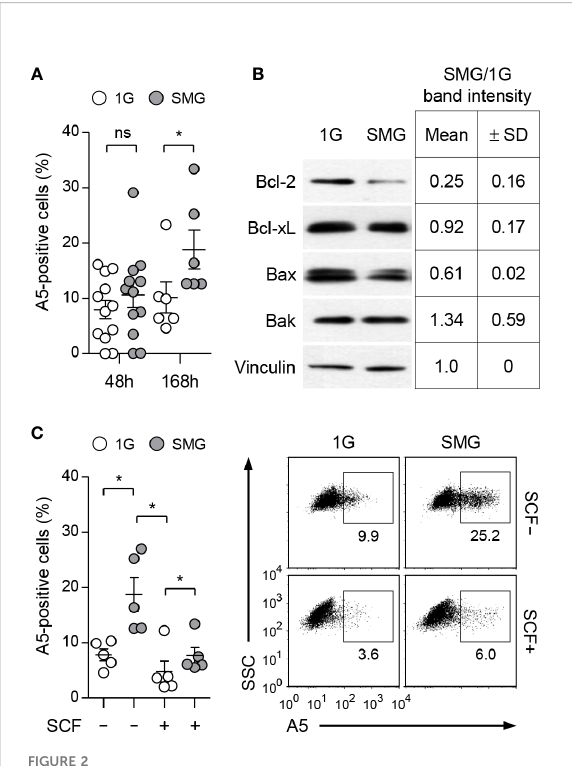
FIGURE 2 Effects of SMG on the apoptosis of mast cells. (A) BMMCs were cultured in IL-3 media at the indicated conditions. Apoptotic death was determined by analyzing Annexin V (A5)-positive stained cells using fl ow cytometry. Data shown are the mean ± SEM (n = 6 to 12). (B) Expression of Bcl-2 family proteins. Cells treated as in panel (A) for 48 h were lysed and analyzed by immunoblot with the indicated antibodies. Vinculin was used as the loading control. Band intensities were quanti fi ed by densitometry and the intensity ratios (SMG/1G) were shown as the mean ± SD (n = 3) from the samples of 3 independent experiments. (C) Cells were cultured with IL-3 ± 100 ng/ml SCF under SMG or 1G for 168 h and stained with PE-conjugated A5. Data shown are representative of 5 experiments (n = 5, mean